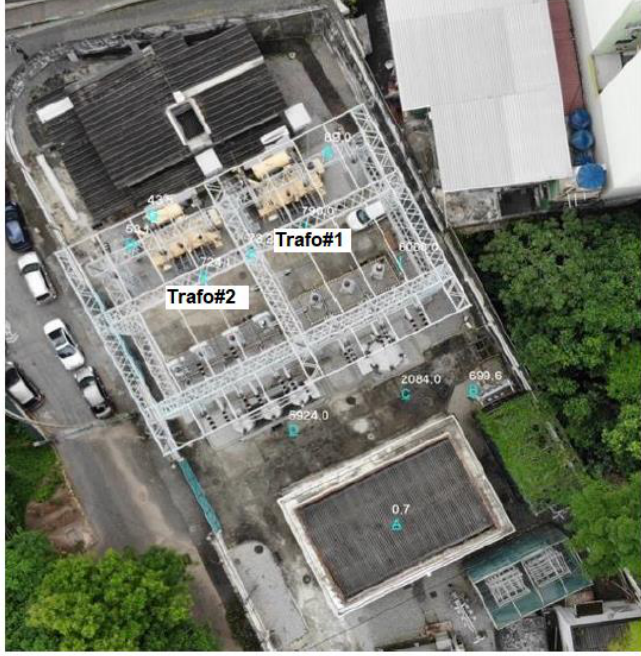
Figure 2. Closer view of the substation, showing the two high-voltage transformers.